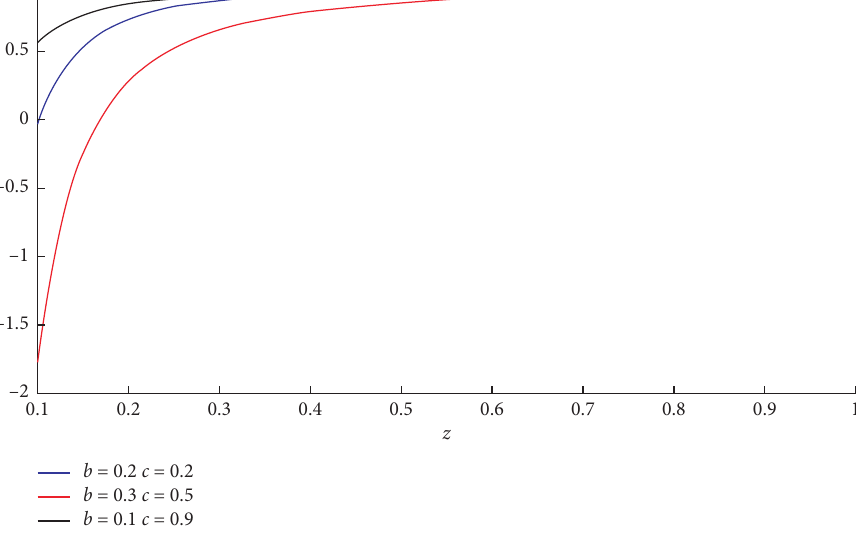
Figure 1: The graph of CDF for equation (18); we take three cases of the values of the parameters: first case b � c � 0 . 2, second case b � 0 . 3 and c � 0 . 5, and final case b � 0 . 1 and c � 0 . 9.